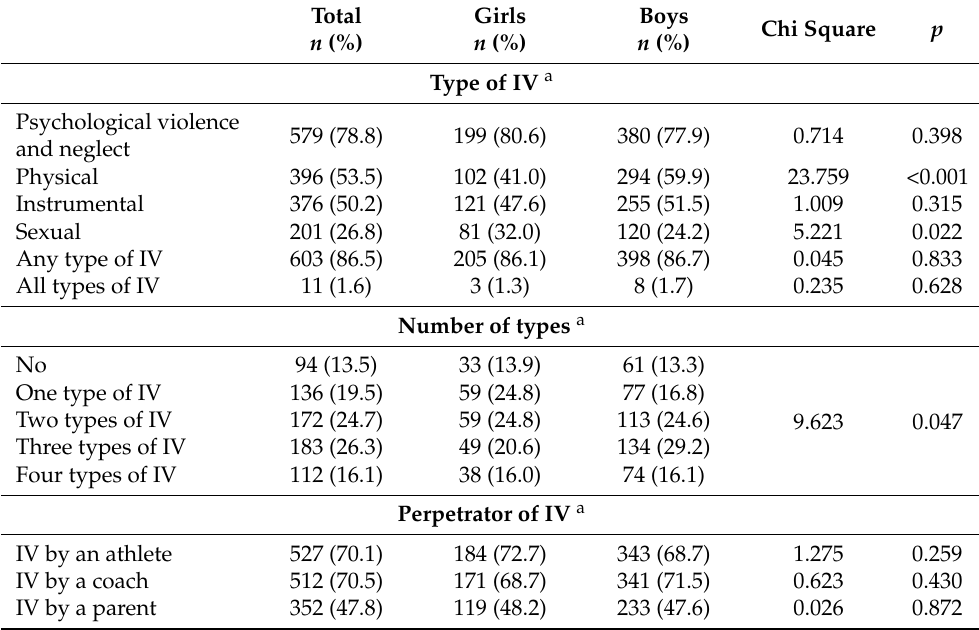
Table 1. Frequencies of each type of IV and the number of different types